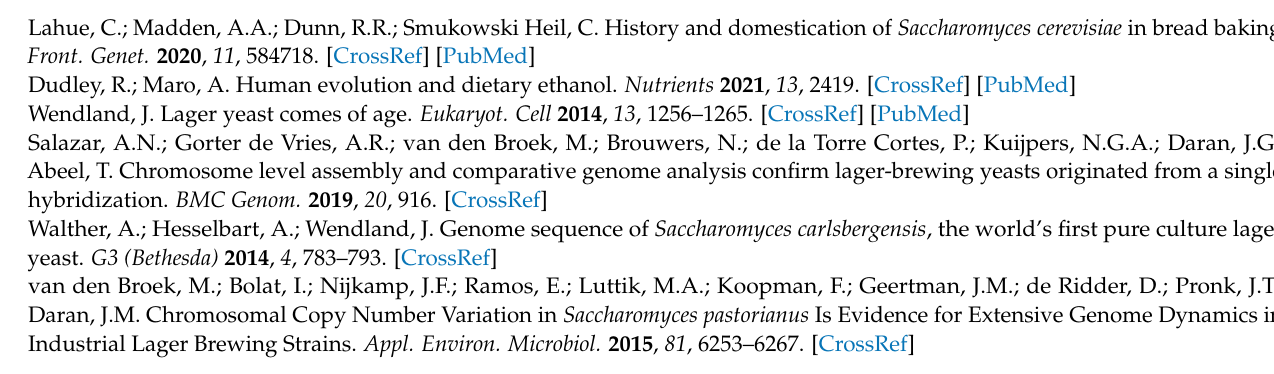
fermentations; Table S2: Aroma data of 28 ◦ C fermentations; Table S3: Aroma data of co-fermentations; Table S4, Figures S1 and S2: additional statistical analyses. References [49–51] are cited in the supplementary